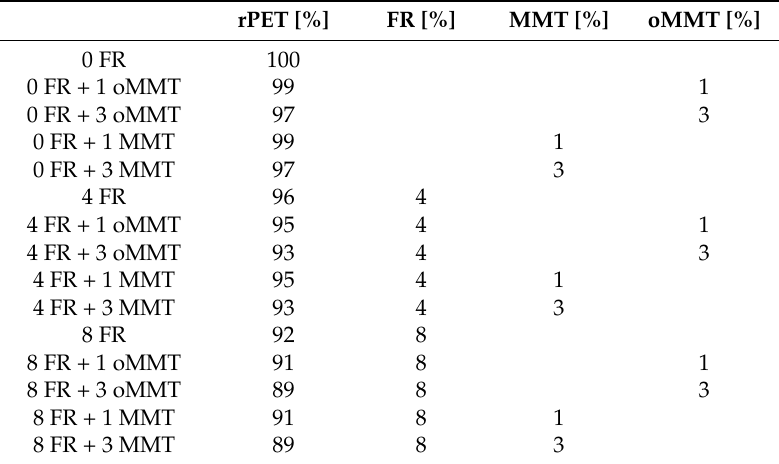
Table 2. Composition of the prepared